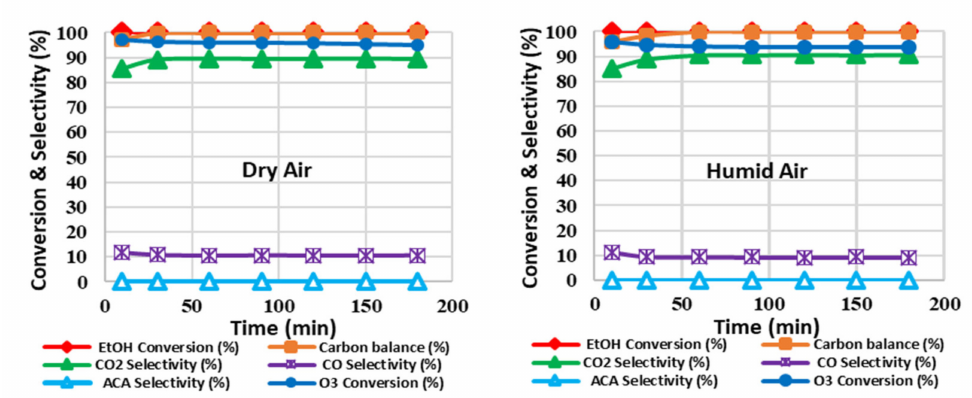
Figure 8. Ethanol conversion, ozone conversion, product selectivity and carbon balance as a function of time on stream in dry ( left ) and humid ( right ) conditions (residence time = 0.1 s, total flow rate = 500 mL · min − 1 , [EtOH] = 10 ppm, [O 3 ] = 70 ppm, T = 60 ◦ C) for the palladium-doped full monolithic catalyst with 54 channels (0.5Pd–5Mn–Ti/ FM ). Table 5. Ethanol oxidation on the impregnated partially plugged monolithic catalysts ( PM ) with 16 channels , in dry and humid air (10% RH) conditions (total flow rate = 500 mL · min − 1 ,